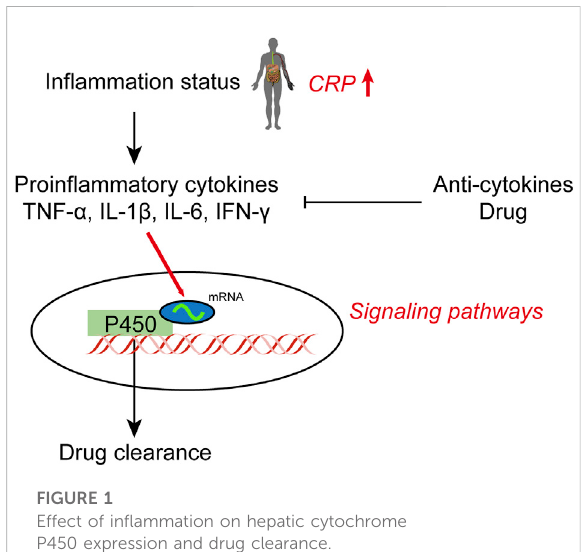
FIGURE 1 Effect of in fl ammation on hepatic cytochrome P450 expression and drug